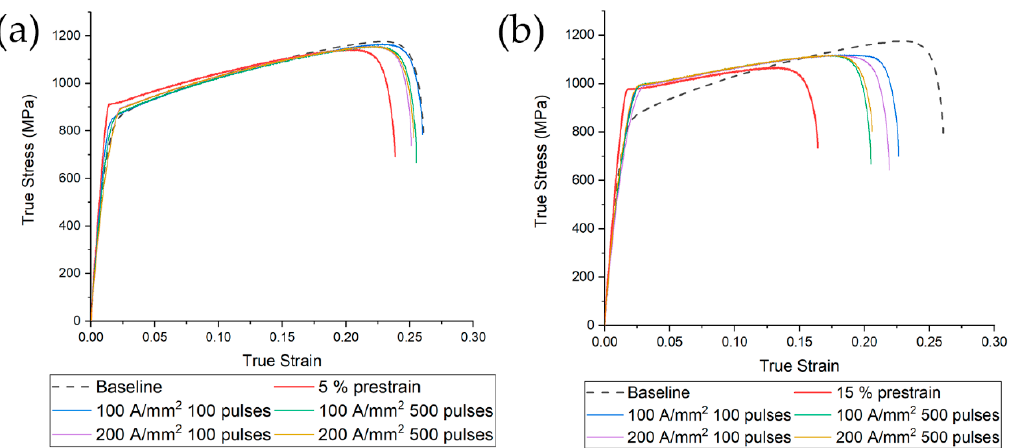
Figure 10. Tensile tests of electropulsed specimens after prestrain of ( a ) 5% and ( b ) 15%. The dashed line represents the room temperature test, while red line is the reference of each categories (5% tensile test ( a ) and 15% tensile test ( b )).